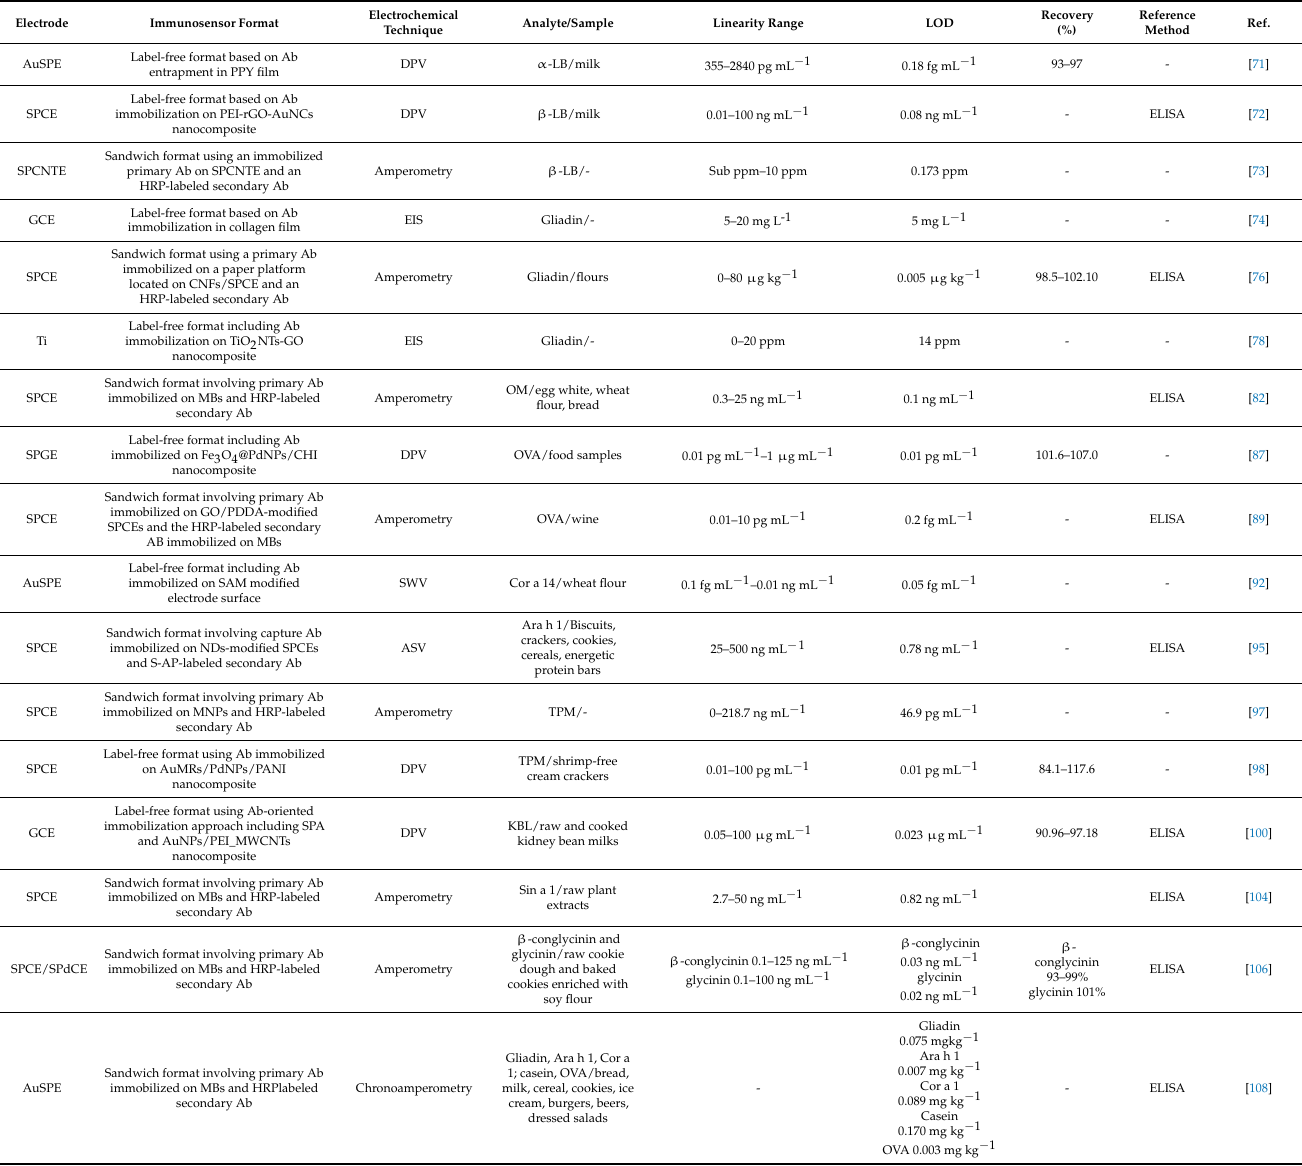
Table 1. Performance of electrochemical immunosensors for allergen